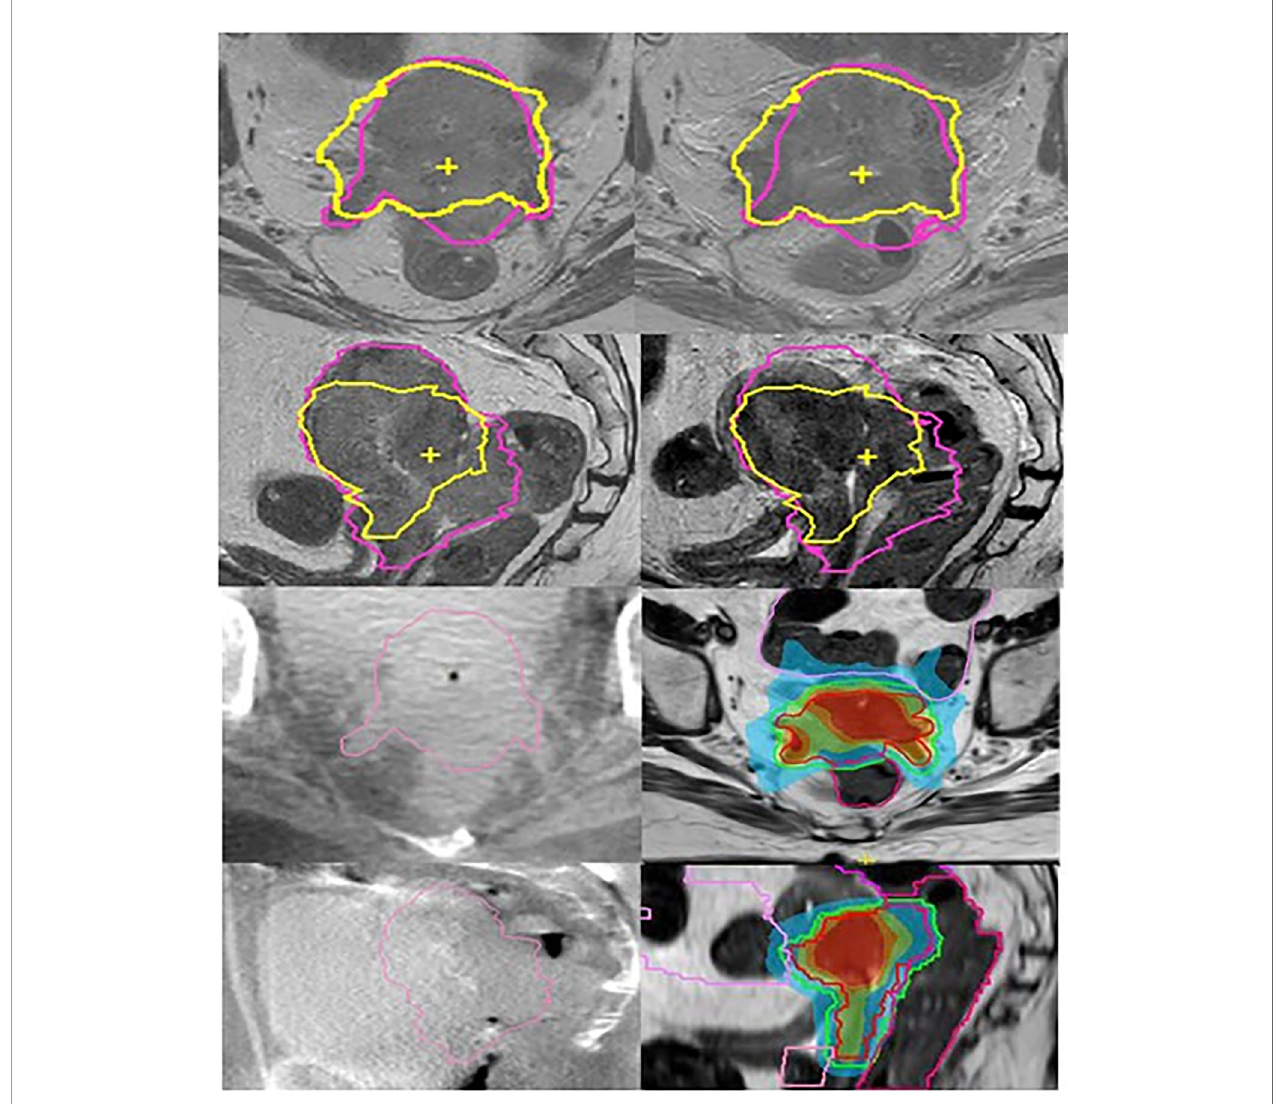
FIGURE 3 | Cervix cancer; MR linac boost of HR-CTV after pelvic EBRT. Left column (top to bottom) transversal and sagittal T2 weighted MRI at time of treatment planning and on-board CBCT scans in the fi rst week of elective EBRT. Right column (top to bottom) MRI scans after 32.4 Gy of elective EBRT and fi rst. MR Linac boost plans. For comparison reasons, the initial and boost HR-CTV contours are shown on the MRI scans (pink at time of treatment planning and yellow after 32.4 Gy EBRT). On the CBCT scans initial HR-CTV is shown. For the MR Linac boost plan, the online delineation of the fi rst fraction for HR-CTV and rectum is shown. The images show the improved visualization of MRI compared to